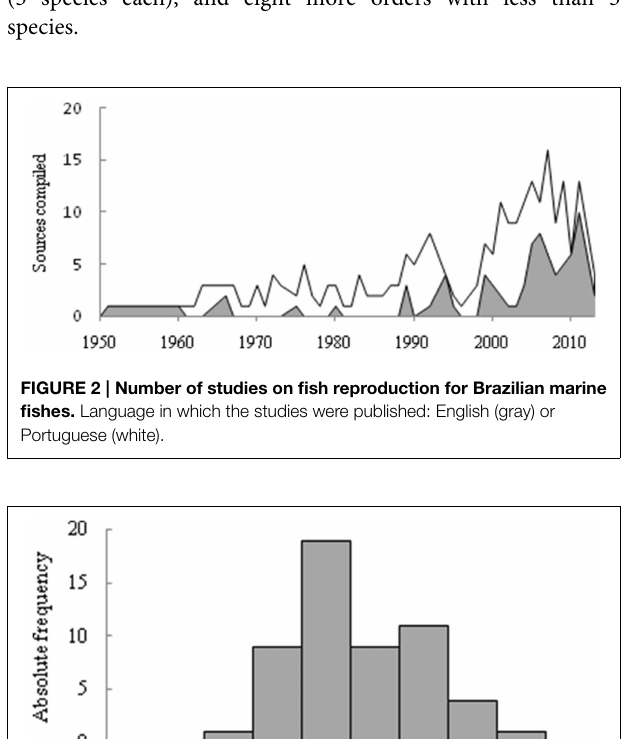
Frontiers in Marine Science |